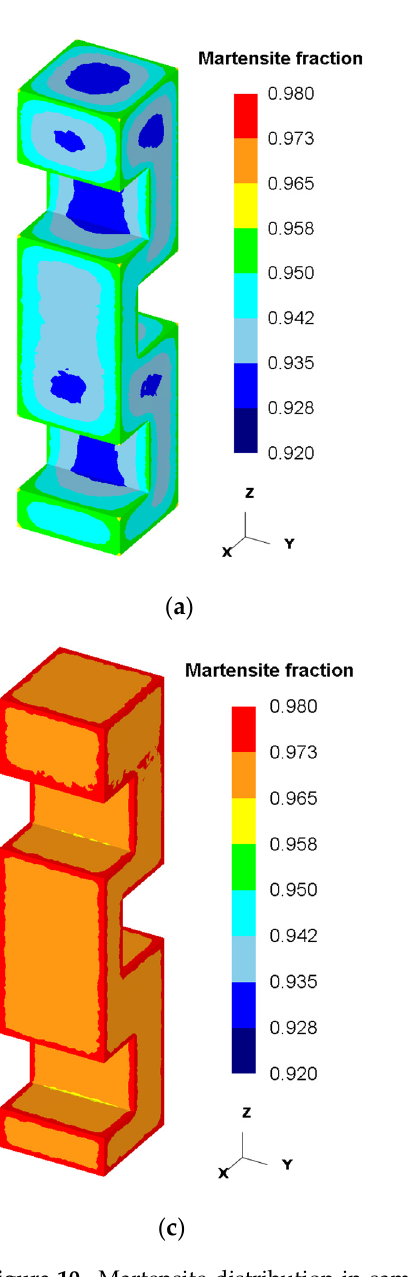
Figure 11. Measured and calculated hardness in quenched samples: ( a ) measured zones and ( b ) experimental hardness results. ( a )